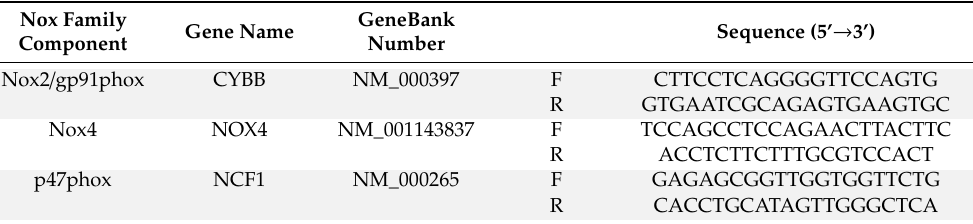
Table 1. Primers utilized for the Nox family